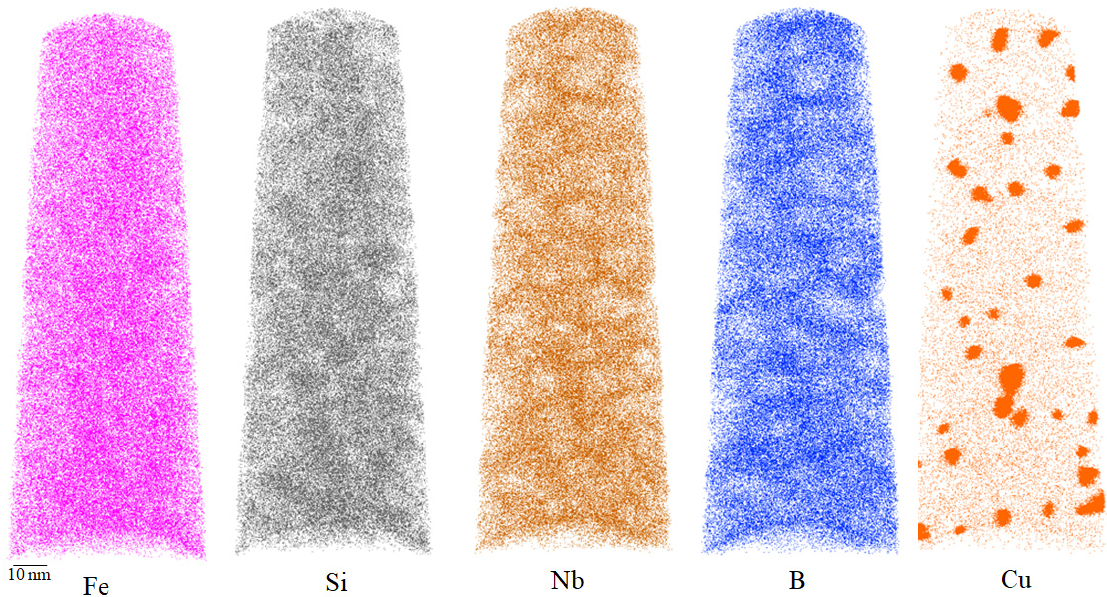
Figure 5. Atom probe analysis of 1.0% sample.